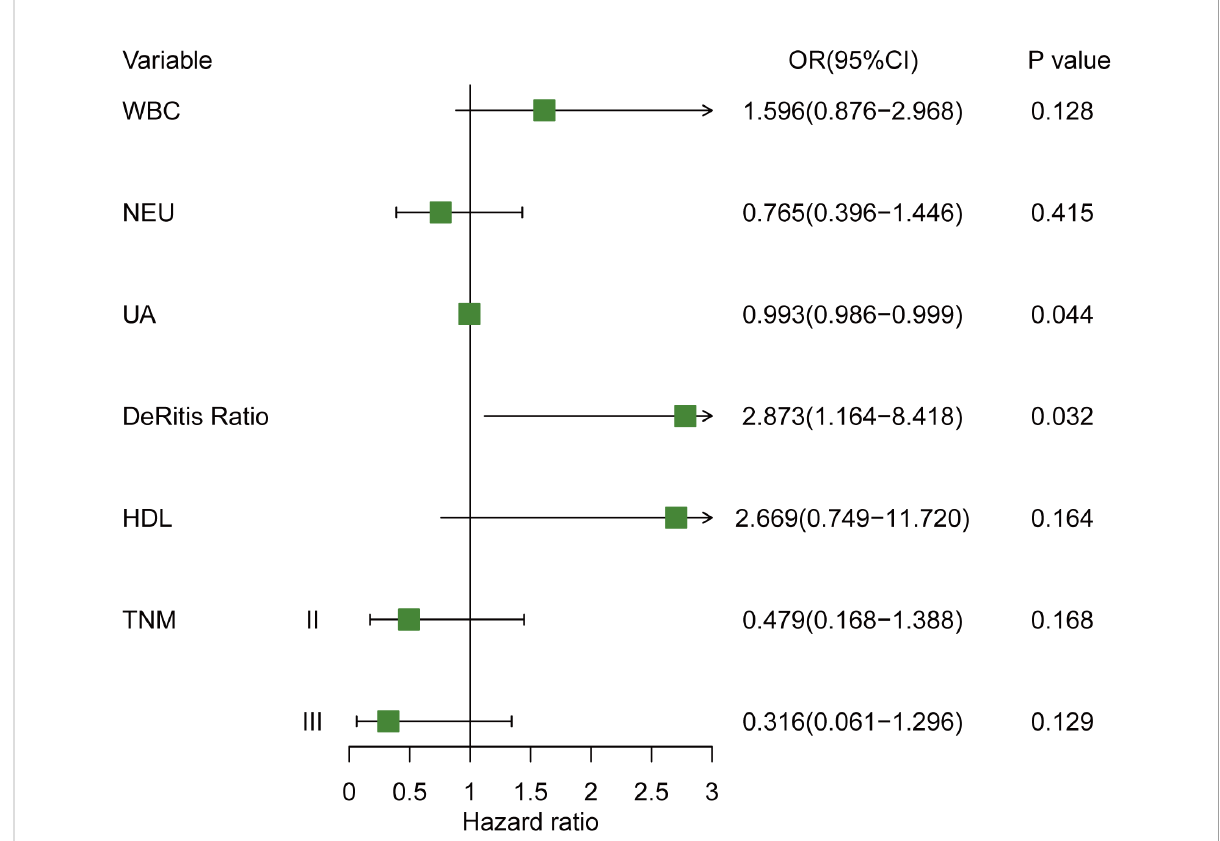
FIGURE 4 Forest plot of hazard ratio for cHER2 status in tHER2- breast cancer patient. Note: WBC (×10 9 /L); NEUs (×10 9 /L), PLT (×10 9 /L), UA (µmol/L).